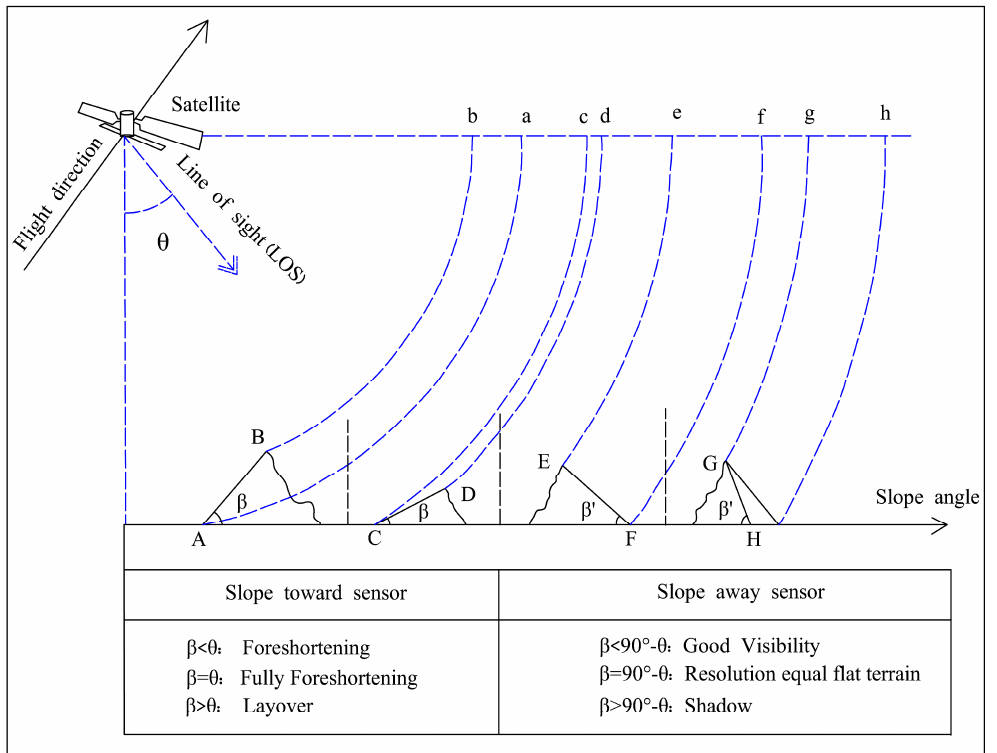
Figure 4. Geometric distortion diagram of radar side view imaging [28].